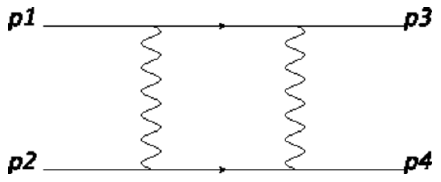
Figure 3 . t-two graviton exchanged between two